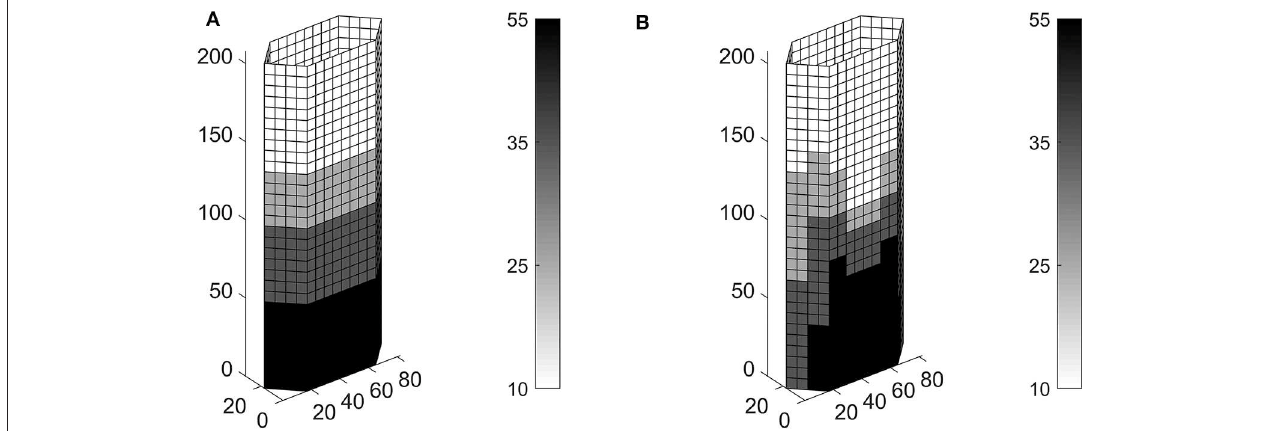
762mm: (A) patch with =